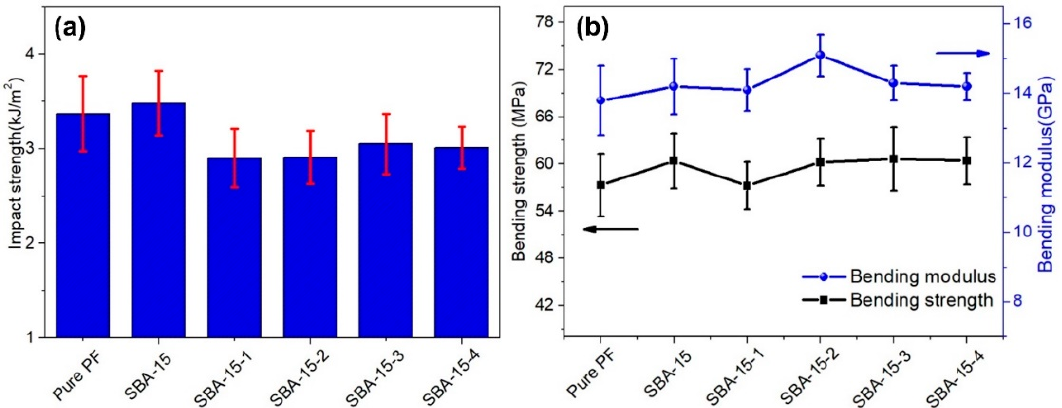
Figure 7. Effects of mesoporous size of SBA-15 on the impact strength of PF nanocomposites ( a ) and